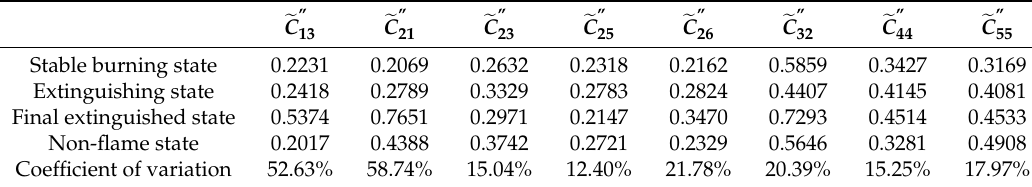
Table 2. Average values of the contour moment invariants.